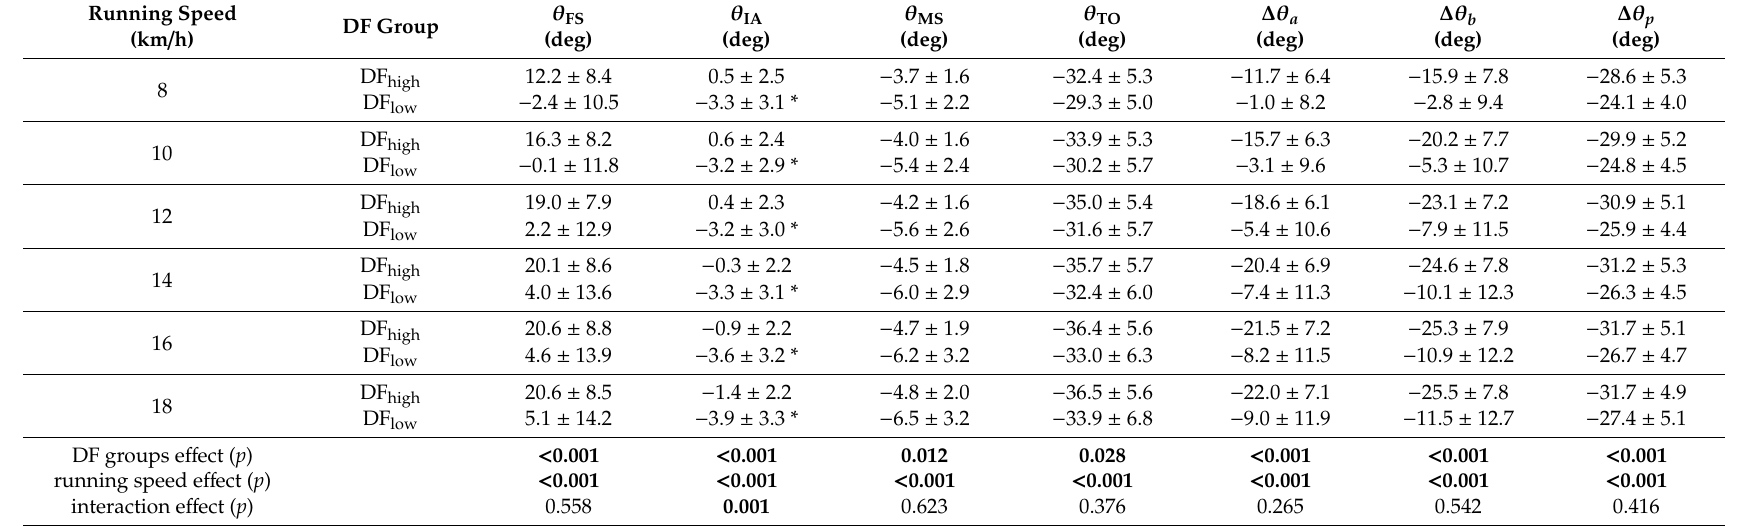
Table 7. Forefoot–rearfoot of the foot segment angle at specific events of the running stance ( θ FS , θ IA , θ MS , and θ TO ) and their range of motions during the di ff erent running stance phases ( ∆ θ a , ∆ θ b , and ∆ θ p ) for the high (DF high ) and low (DF low ) duty factor running groups at the di ff erent running